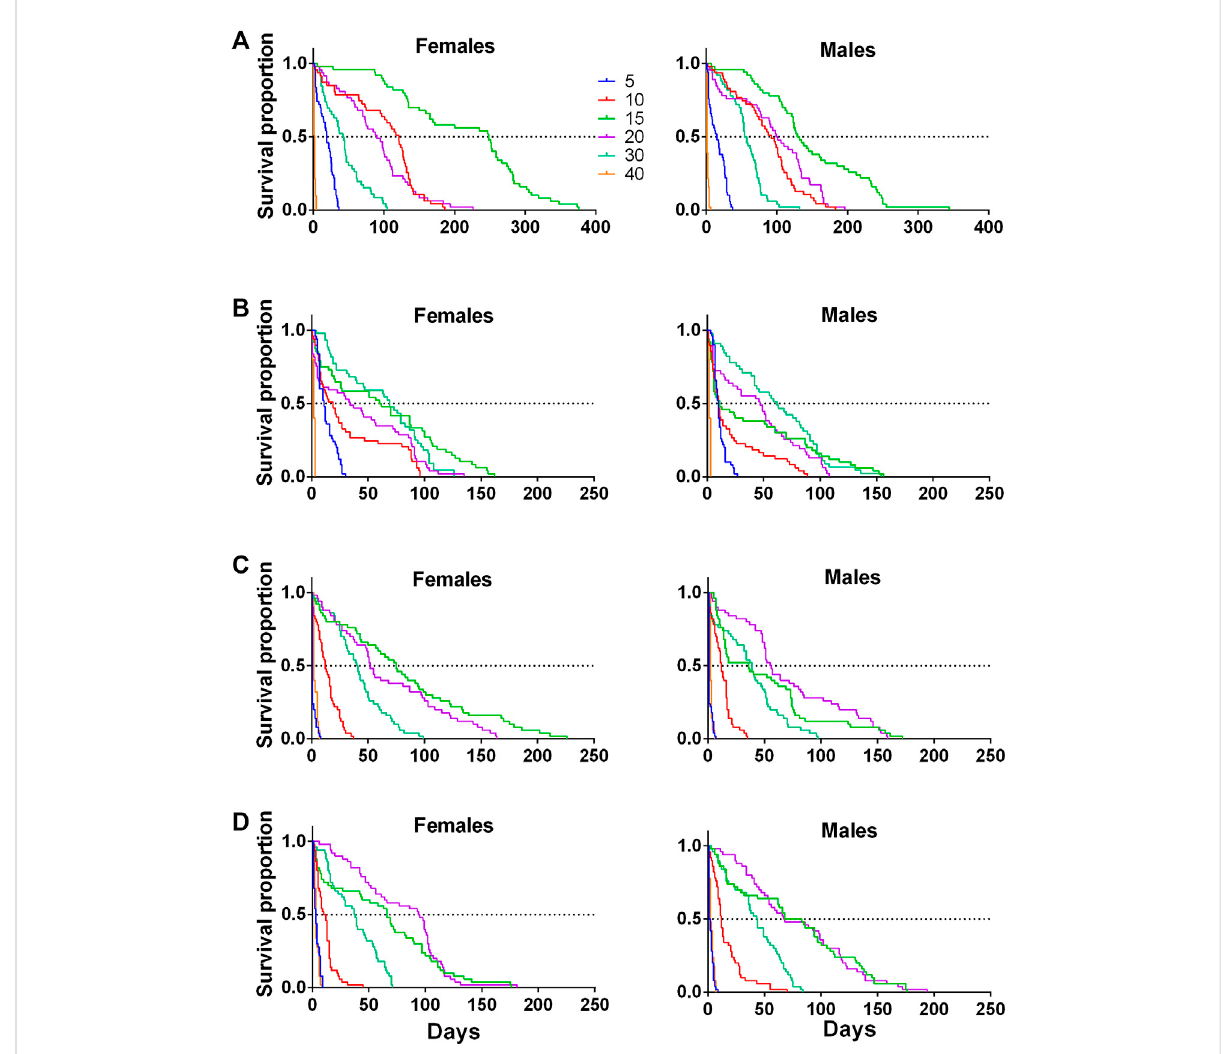
FIGURE 3 Kaplan-Meier survival curves of females and males of four pestiferous Anastrepha species exposed to different temperatures (5, 10, 15, 20, 30,40 ° C) in bioclimatic chambers (A) A. ludens, (B) A. obliqua (C) A. serpentina and, (D) A. striata